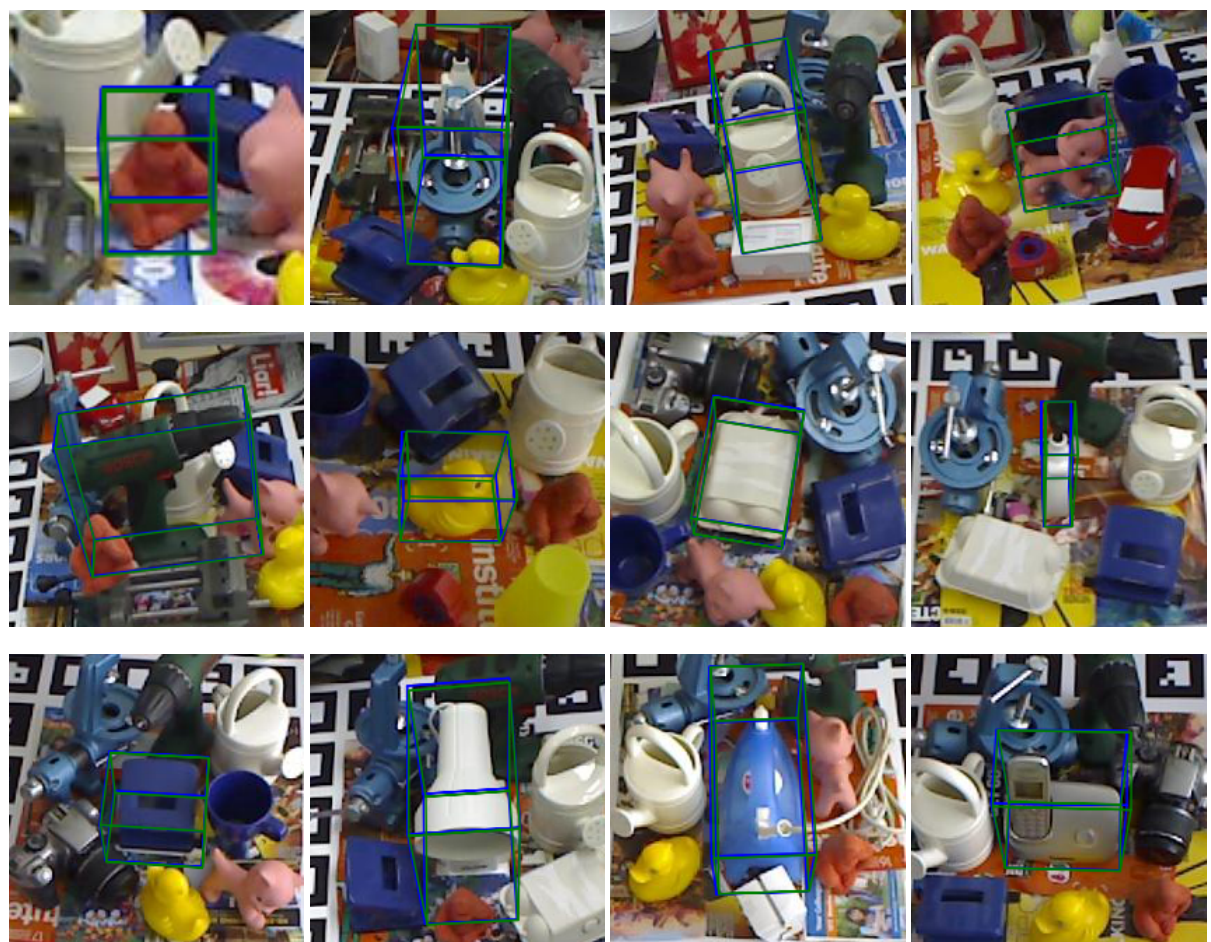
Figure 8. Visualizations of results on the LINEMOD